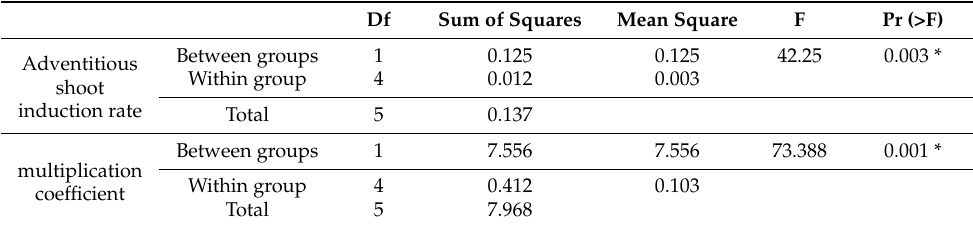
Table 6. Variance analysis of different root burying methods on adventitious shoot induction rate and multiplication coefficient.